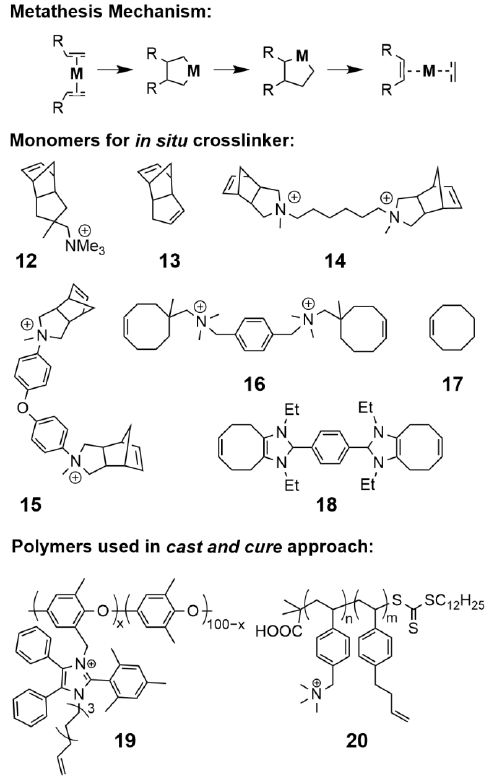
Figure 12 . Metathesis crosslinking mechanism and corresponding